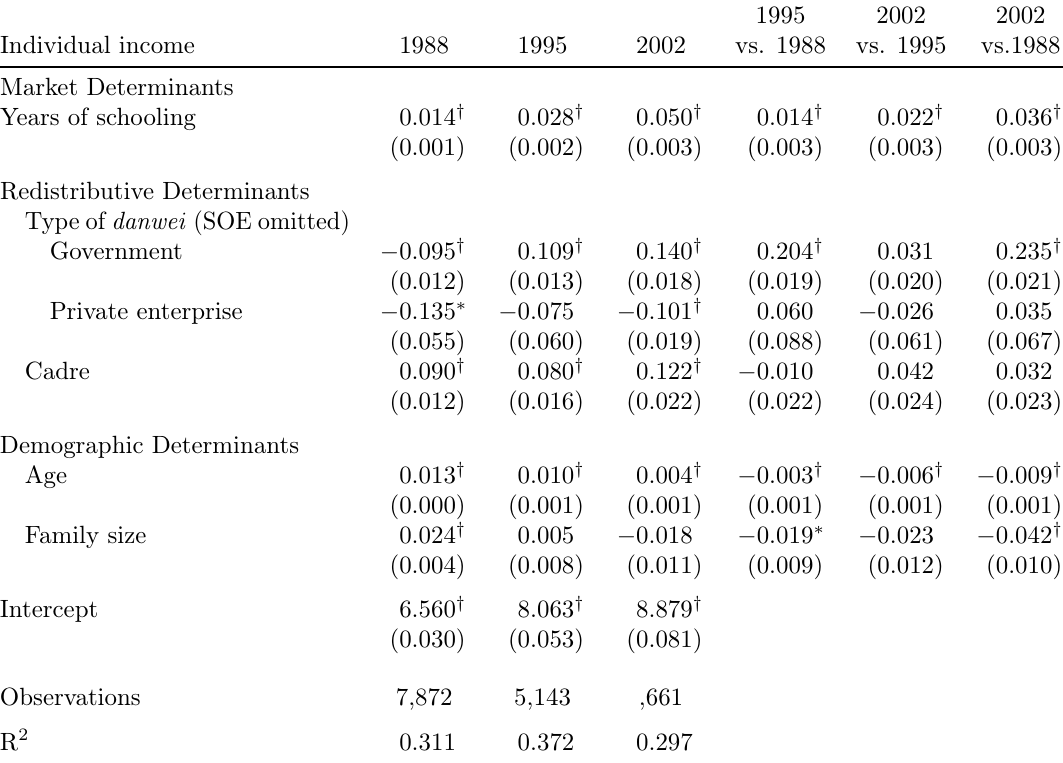
Table 4: Changing Determinants of Income with Regional Fixed